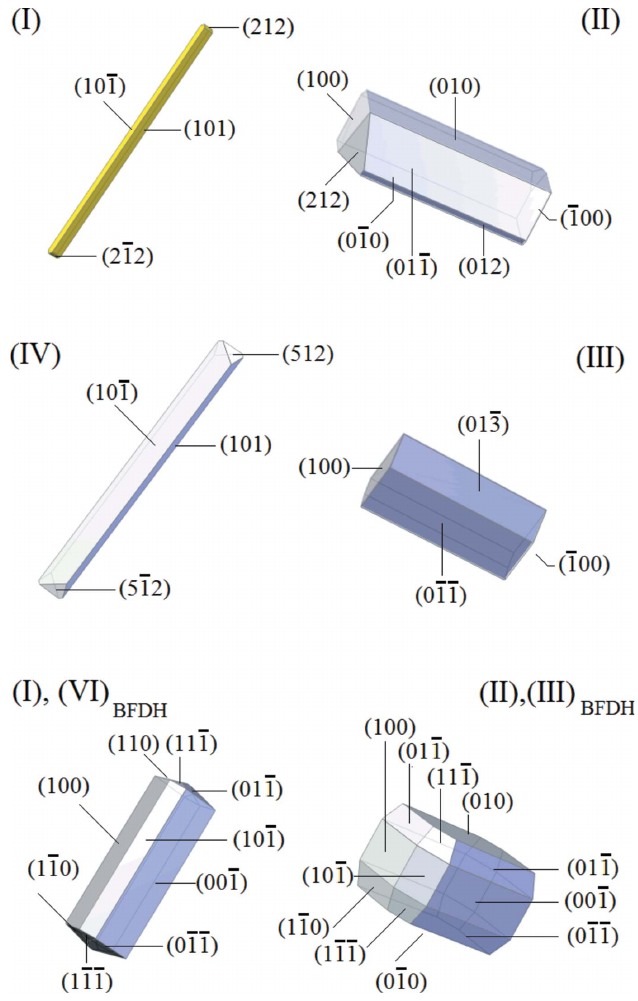
Figure 3 The morphologies of the samples used to obtain structures for this report and the result of BFDH calculations based on the